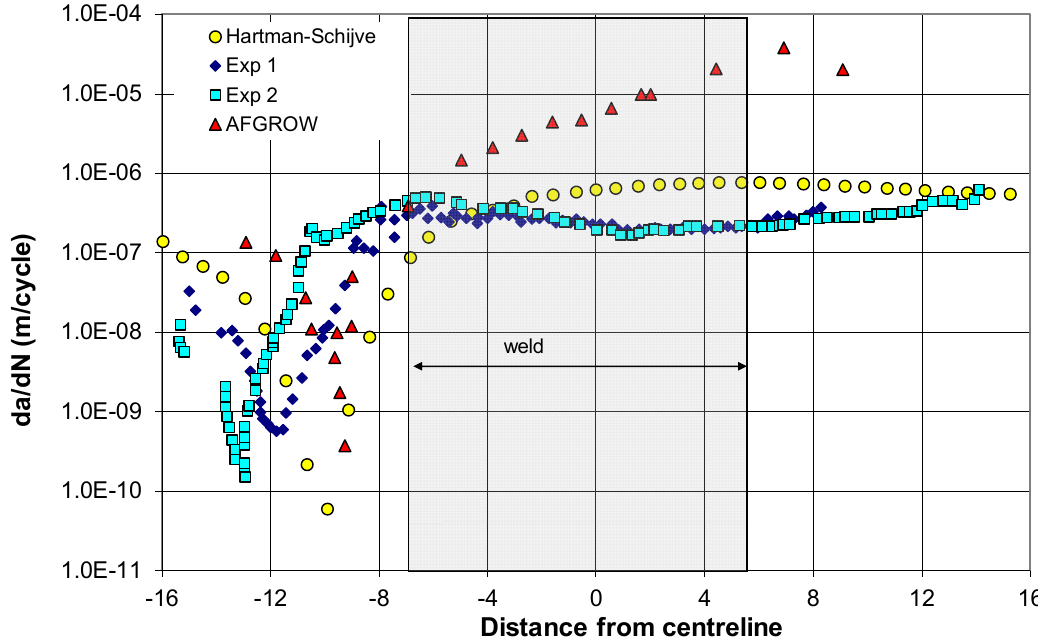
Figure 4. Comparison of the measured values, from [72], and computed crack growth rates.